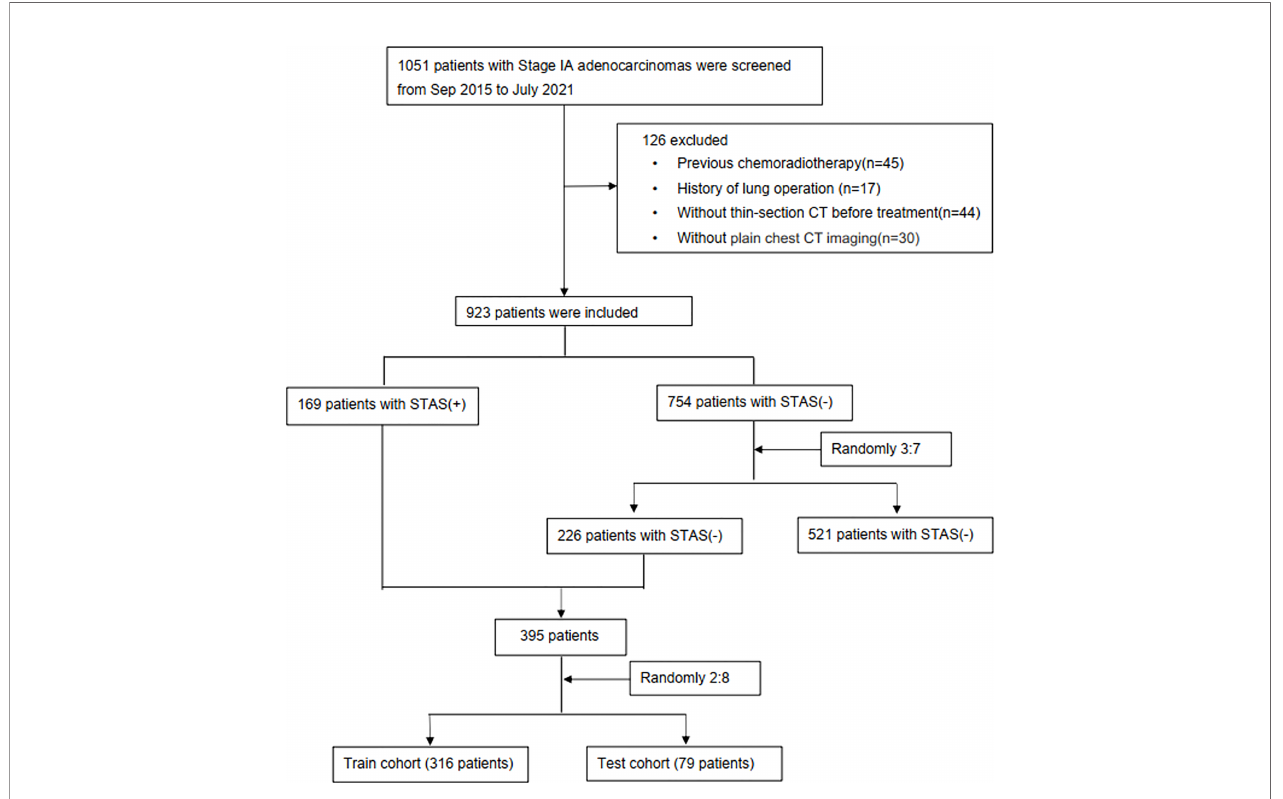
FIGURE 1 | Study fl owchart. STAS, spread through air spaces; STAS+, presence of STAS; STAS-, absence of